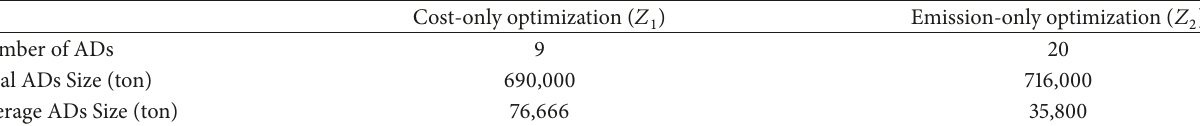
Table 4: Number of ADs opened and their relative size variation.